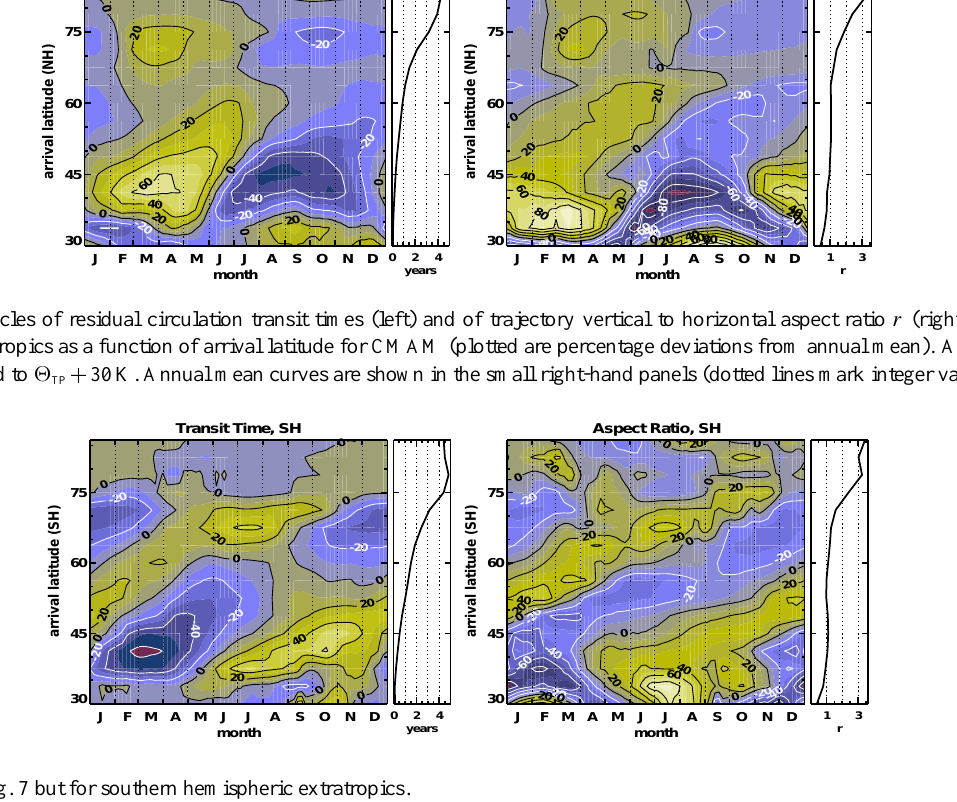
Fig. 9. Same as Fig. 7 but for the tropics. Note annual mean transit times are given in days here. Contours and color shading are limited to less than 100% in the case of the aspect ratio (right). Latitudes and times of exceedingly large aspect ratio mark maximum tropical upwelling there (i.e. corresponding trajectories have an almost vanishing horizontal range).